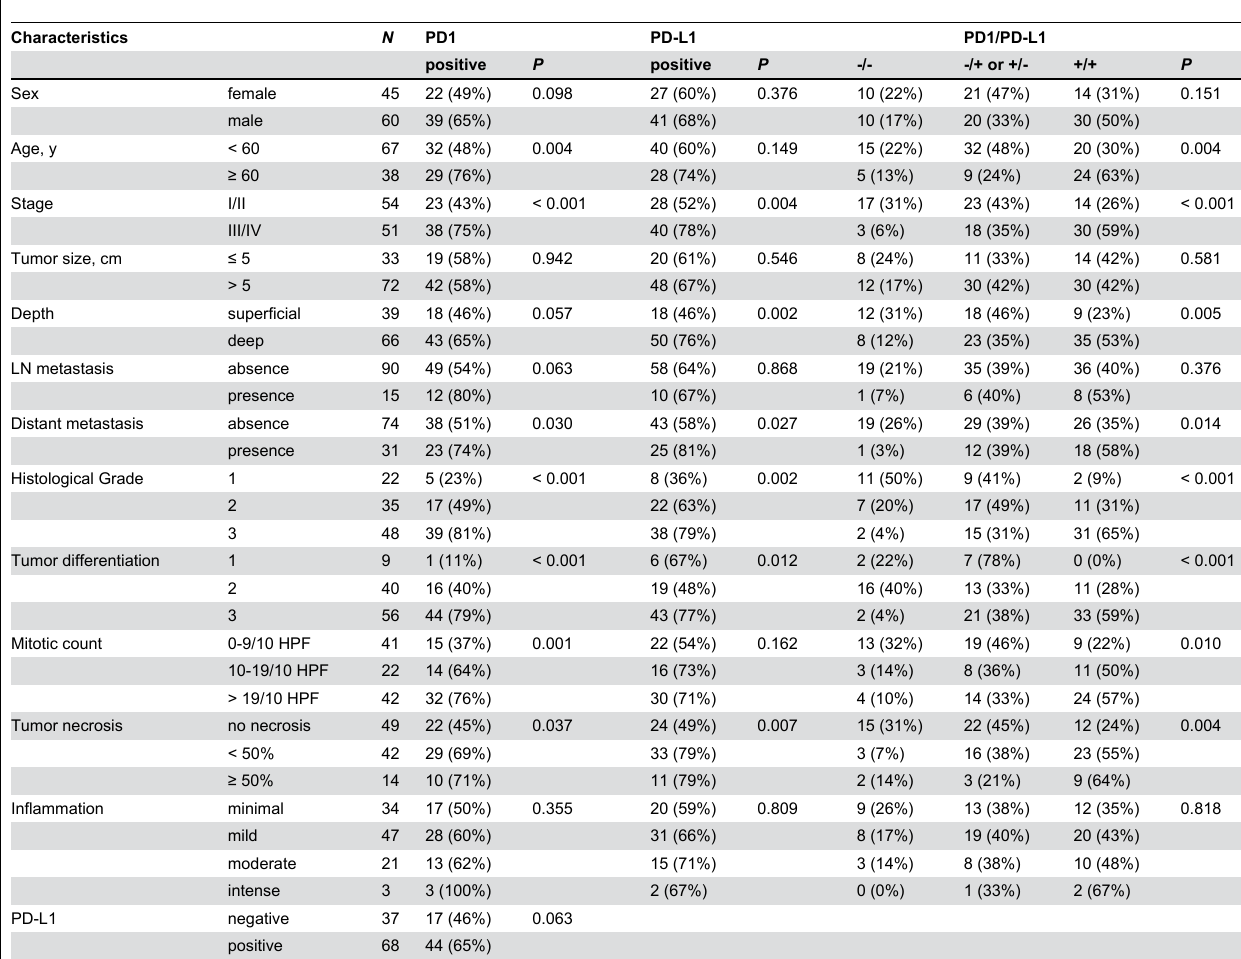
Table 2. Clinicopathologic variables and the expressional status of PD1 and PD-L1 in soft-tissue sarcomas.